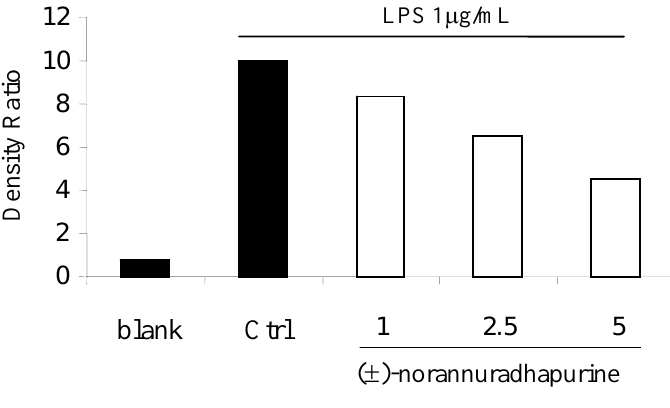
Figure 4 . Effect of (±)-norannuradhapurine and LPS-induced COX-2 protein expression in RAW 264.7 cells.